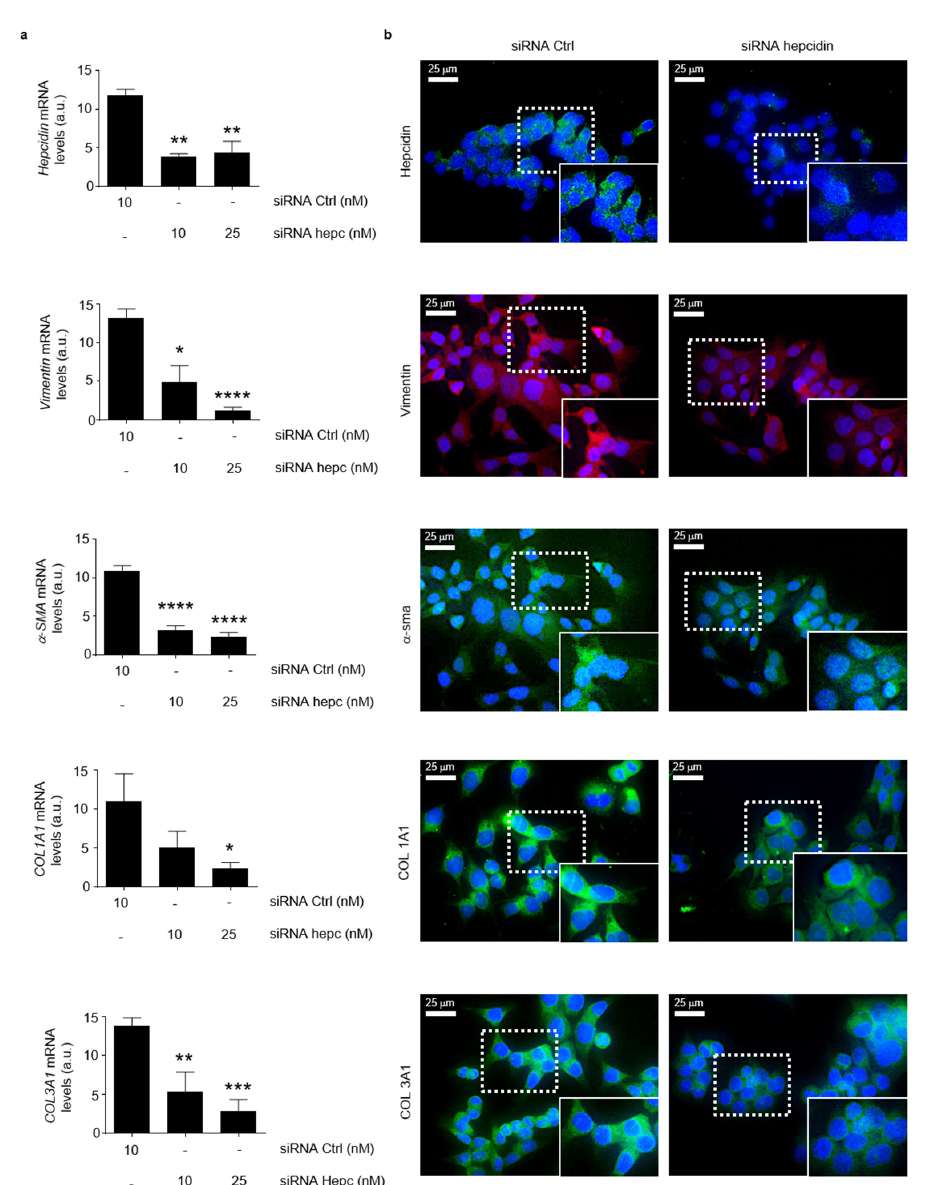
Figure 8. Silencing of hepcidin in CRC cells is associated with a significant reduction of mesenchymal markers. ( a ) Hepcidin, Vimentin, α -SMA, COL1A1 and COL1A3 RNA transcripts were evaluated in HCT-116 cells transfected for 24 h with either a control siRNA (10 nM) or hepcidin siRNA Hepcidin (10 and 25 nM) by real-time PCR, and values were normalized to β -actin RNA. Values are expressed in arbitrary units (a.u.) and indicate mean ± SD of 4 experiments; Hepcidin: control siRNA versus hepcidin siRNA 10 nM, ** p < 0.01; control siRNA versus hepcidin siRNA 20 nM, ** p < 0.01; Vimentin: control siRNA versus hepcidin siRNA 10 nM, * p < 0.05; control siRNA versus hepcidin siRNA 20 nM, **** p < 0.0001; α -SMA: control siRNA versus hepcidin siRNA 10 nM, **** p < 0.0001; control siRNA versus hepcidin siRNA 20 nM, **** p < 0.0001; COL1A1: control siRNA versus hepcidin siRNA 10 nM, ns; control siRNA versus hepcidin siRNA 20 nM, * p < 0.05; COL1A3: control siRNA versus hepcidin siRNA 10 nM, ** p < 0.01; control siRNA versus hepcidin siRNA 20 nM, *** p < 0.001. ( b ) Representative images of immunofluorescence staining for hepcidin (green), Vimentin (red), α - SMA (red), COL1A1 (green) and COL1A3 (green) in HCT-1116 cells transfected with either a control siRNA (10 nM) or hepcidin siRNA Hepcidin (25 nM) for 24 h; nuclei are stained with 4 (cid:48) ,6-diamidino- 2-phenylindole (DAPI)